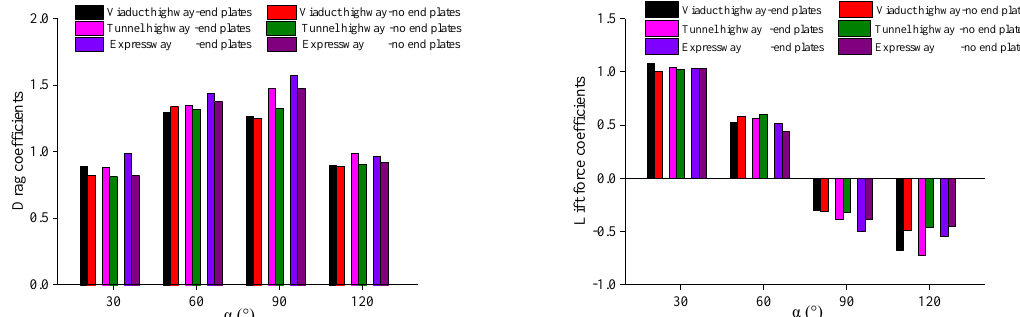
Figure 18. Aerodynamic coefficients comparison for the end plates effect.